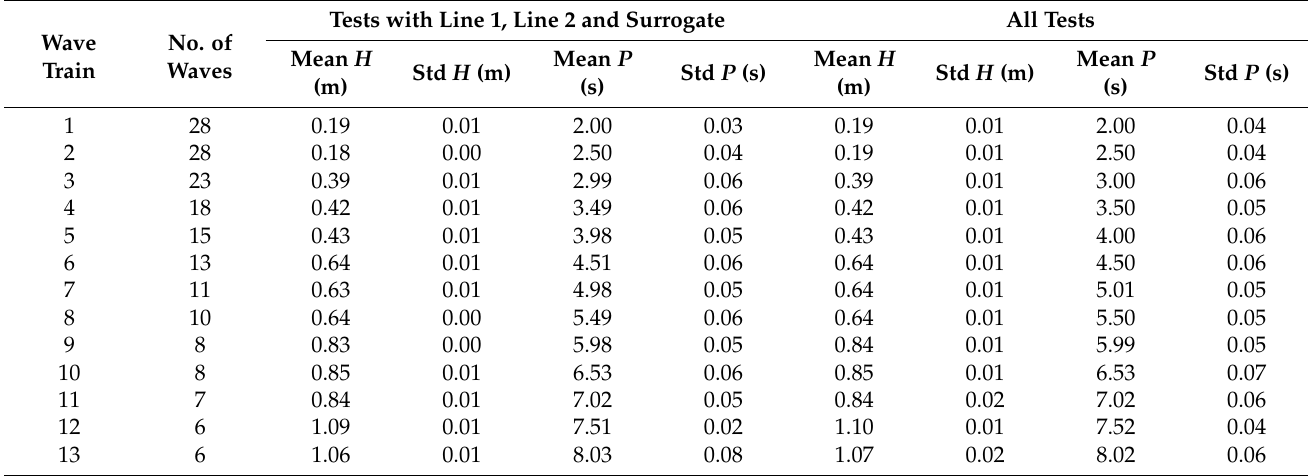
Table 2. Wave height and period of individual waves at wave gauge